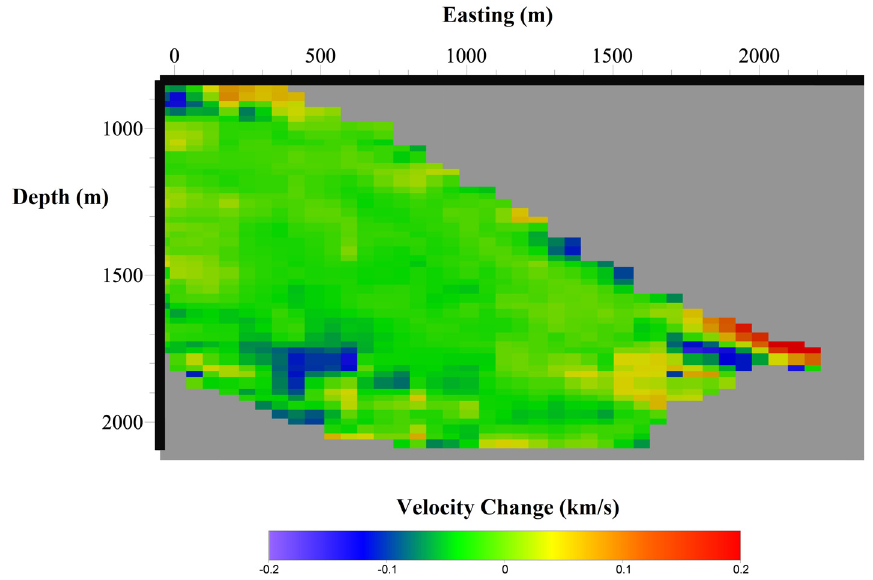
Figure 8. Tomogram of the change in velocity for the second synthetic test, using the velocity model in Figure 6a at a northing slice of − 290